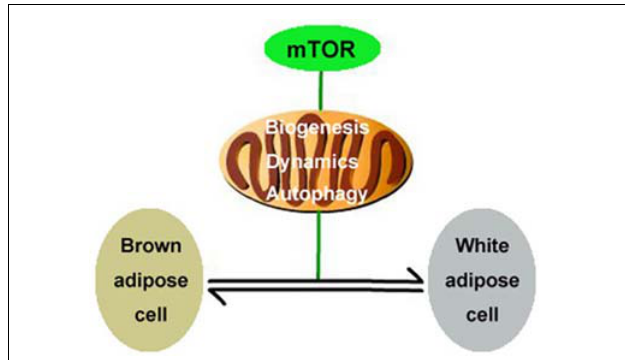
FIGURE 6 | Illustration of putative signaling pathways. mTOR signaling pathway regulates mitochondrial biogenesis, mitochondrial dynamics, and mitophagy in brown adipocytes and therefore plays an important role in modulating the transformation of the adipocyte